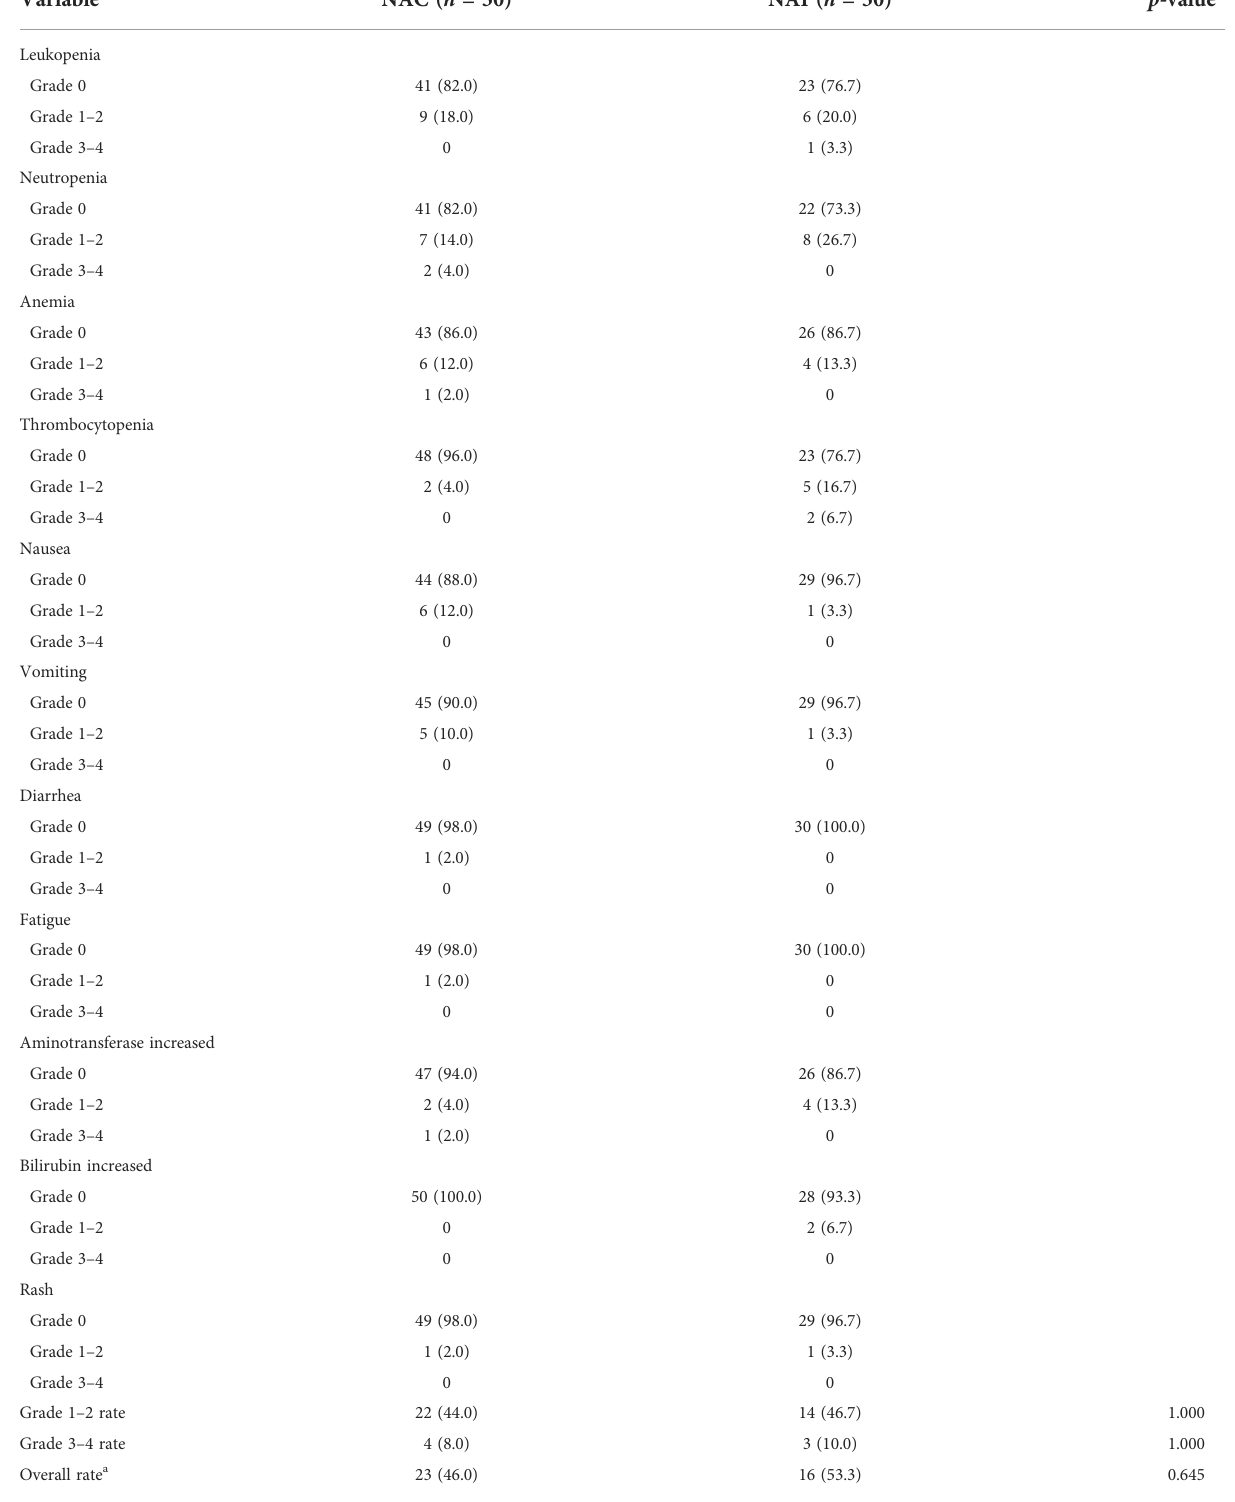
TABLE 2 Adverse